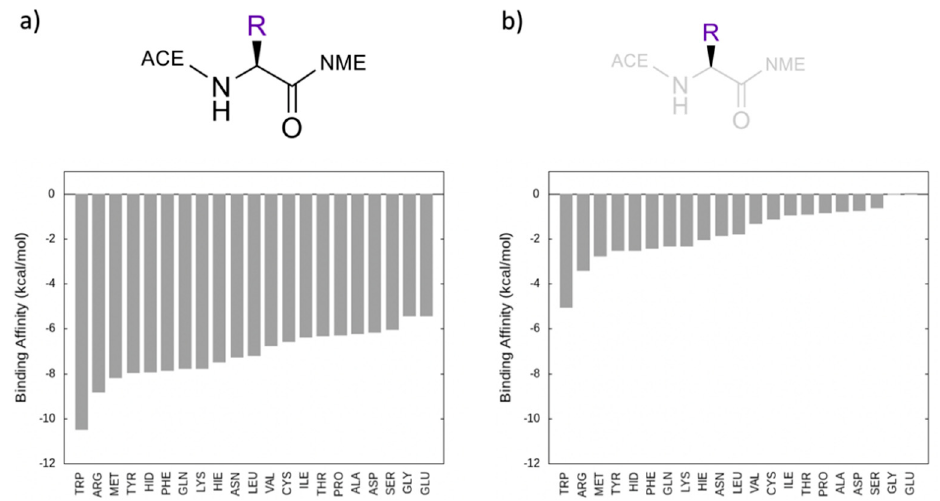
Figure 1. Binding energy between the ( a ) whole capped amino acid and ( b ) amino acid side chain and C 60 calculated by MM/GBSA for the twenty proteinogenic amino acids.